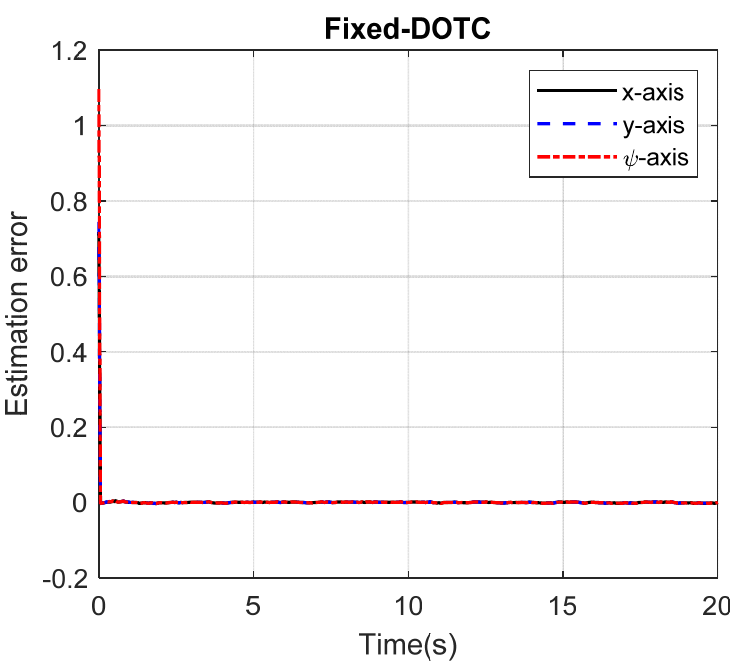
Figure 3. The estimation errors under the Fixed ‐ DOTC in part 1.